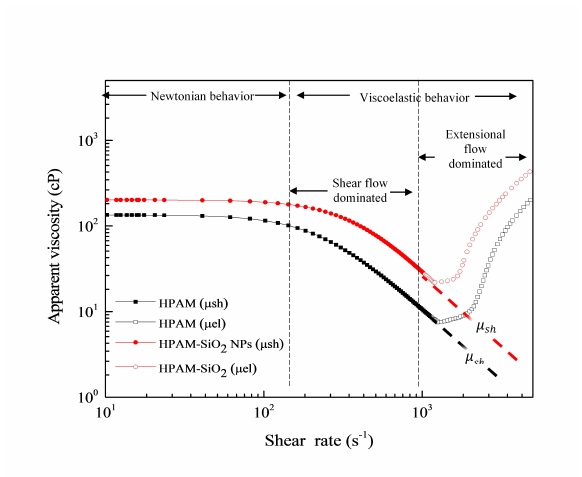
Fig. 10. Apparent viscosity of HPAM and HPAM-SiO 2 NPs in porous media at temperature 80°C.